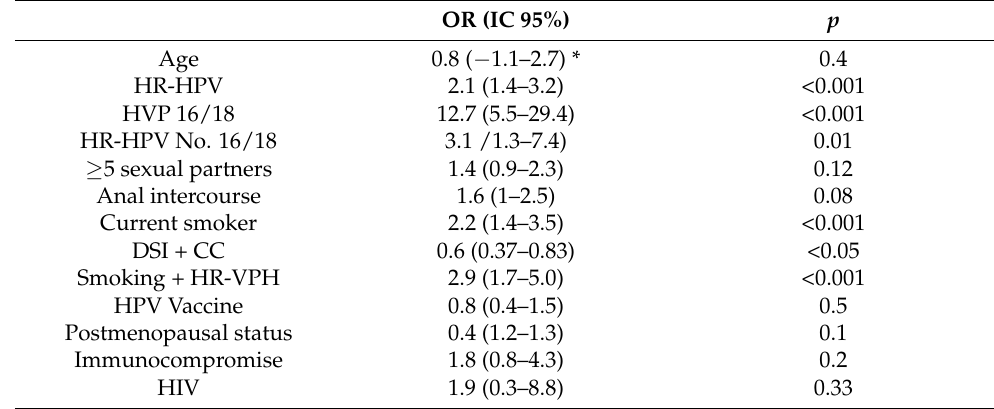
Table 2. Univariate analysis of the features and their association with H-SIL/CIN2+ in the final